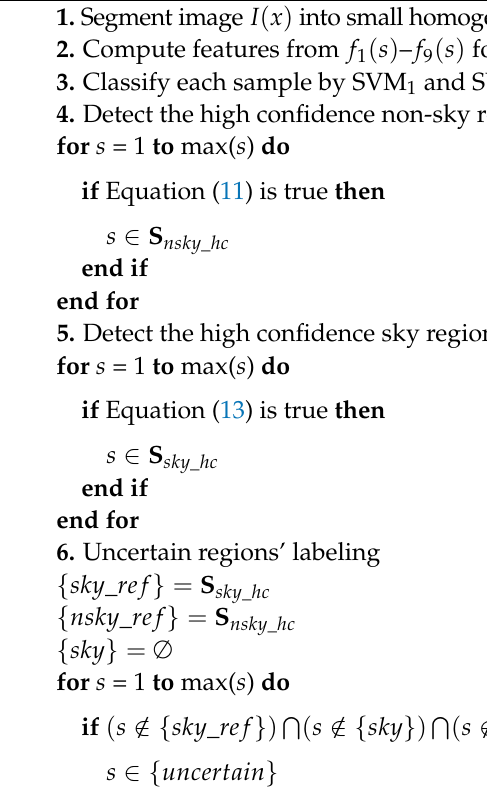
Algorithm 1: Sky detection